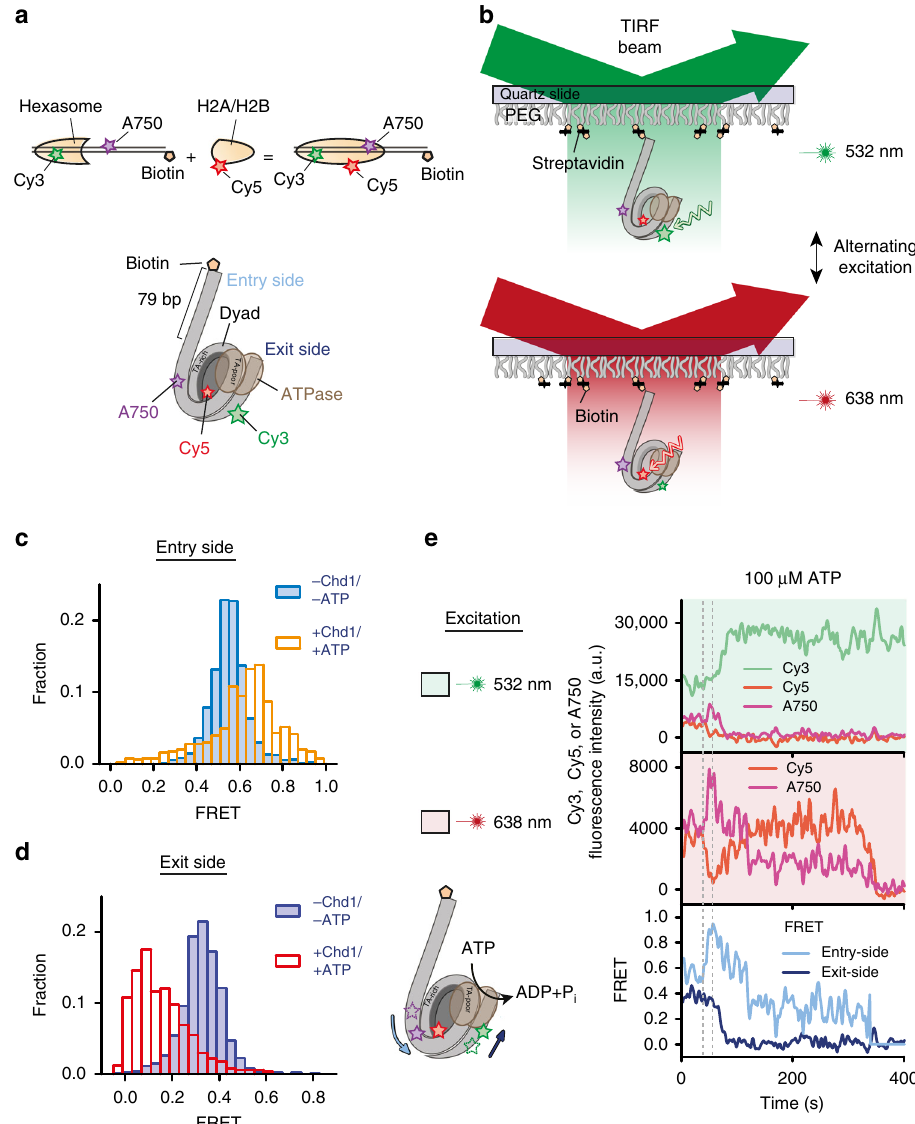
Fig. 1 Simultaneous detection of entry- and exit-side movements by three-colour FRET. a Cartoon representations of the three-colour labelling scheme. The ATPase motor of the remodeller is shown in brown and Cy3, Cy5, and Alexa750 are depicted by green, red, and purple stars, respectively. The entry side is on the TA-poor side of the 601 sequence, and the exit side is on the TA-rich side. b Schematic of FRET detection with alternating 532 nm and 638 nm laser excitation of nucleosomes labelled with Cy3, Cy5, and Alexa750. Entry-side ( c ) and exit-side ( d ) FRET histograms constructed from 1543 traces before (solid bars) and 507 traces after (open bars) remodelling by 300 nM Chd1 in the presence of 1 mM ATP. e Representative Cy3 (green), Cy5 (red), and Alexa750 (purple) fl uorescence and FRET time traces (entry-side, light blue; exit-side, dark blue) showing sliding of a single nucleosome after addition of 300 nM Chd1 and 1 mM ATP. Time traces were recorded with alternating 532 nm and 638 nm laser excitation, as indicated by the areas shaded in green and red, respectively. The dashed lines indicate the onset of changes in entry-side and exit-side FRET. Entry- and exit-side FRET values, determined simultaneously in the same experiment using alternating laser excitation, resembled those separately determined using corresponding two-colour FRET nucleosomes possessing Cy5-H2B and either an exit- or entry-side DNA fl uorophore, respectively (Supplementary Fig. 2). Source data are provided as